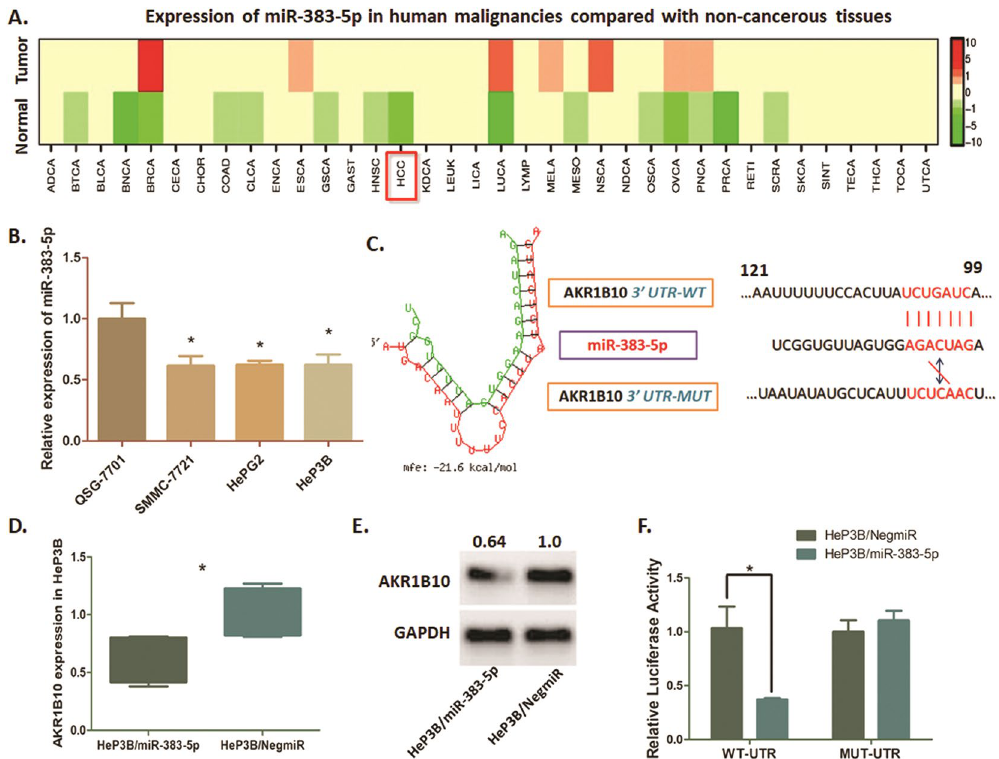
Figure 6. Degeneration of AKR1B10 in HeP3B cells directly regulated by miR-383-5p. ( A ) Expression profile heatmap of miR-383-5p in differential human malignancies generated by dbDEMC (Version 2.0) software. The bar indicates the expression level of objective genes by using color change, from green for low expression to red for high expression. MiR-383-5p is declined in HCC tissues compared with normal liver tissues. ( B ) MiR- 383-5p expression detected by qRT-PCR. MiR-383-5p was significantly lower in HCC cells than that in QSG- 7701 cells ( * P < 0.05). ( C ) The left graph shows the minimum free energy (MFE) of the combination between miR-383-5p and AKR1B10 mRNA 3 ′ -UTR, and the absolute number of this combination is 21.6 kcal/mol. The right graph is the scheme for the predicted miR-383-5p binding site in the wild type AKR1B10 mRNA 3 ′ UTR (3 ′ UTR-WT), and in the mutant construct (3 ′ UTR-MUT). ( D ) QRT-PCR assay demonstrating the effect of miR-383-5p on AKR1B10 mRNA status in HeP3B cells. AKR1B10 expression was significantly suppressed by over-expressing miR-383-5p in HeP3B cells. ( E ) Western blot analysis shows the degeneration of AKR1B10 expression at protein status in HeP3B cells. AKR1B10 protein was significantly decreased after introducing miR-383-5p into HeP3B cells. The blot was cropped and matched according to the columns from the same gel. ( F ) The direct interaction between miR-383-5p and AKR1B10 was detected by Dual-luciferase reporter assay. Over-expression of miR-383-5p in HeP3B cells (HeP3B/miR-383-5p) significantly decreased the luciferase signal of AKR1B10/pMIR/WT compared with the negative control (HeP3B/NigmiR) ( * P < 0.05). Mutation of the putative miR-383-5p-binding site abolished this suppressive